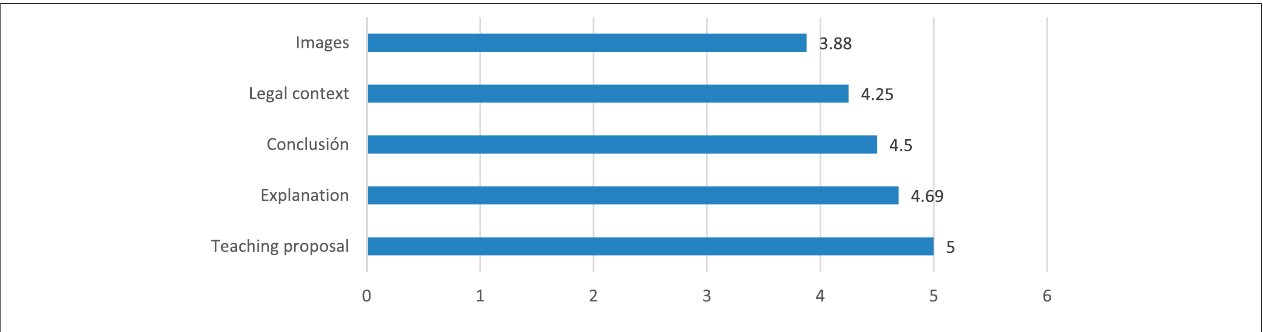
FIGURE 8 | Mean evaluation of the cooperative work on the Way of St.